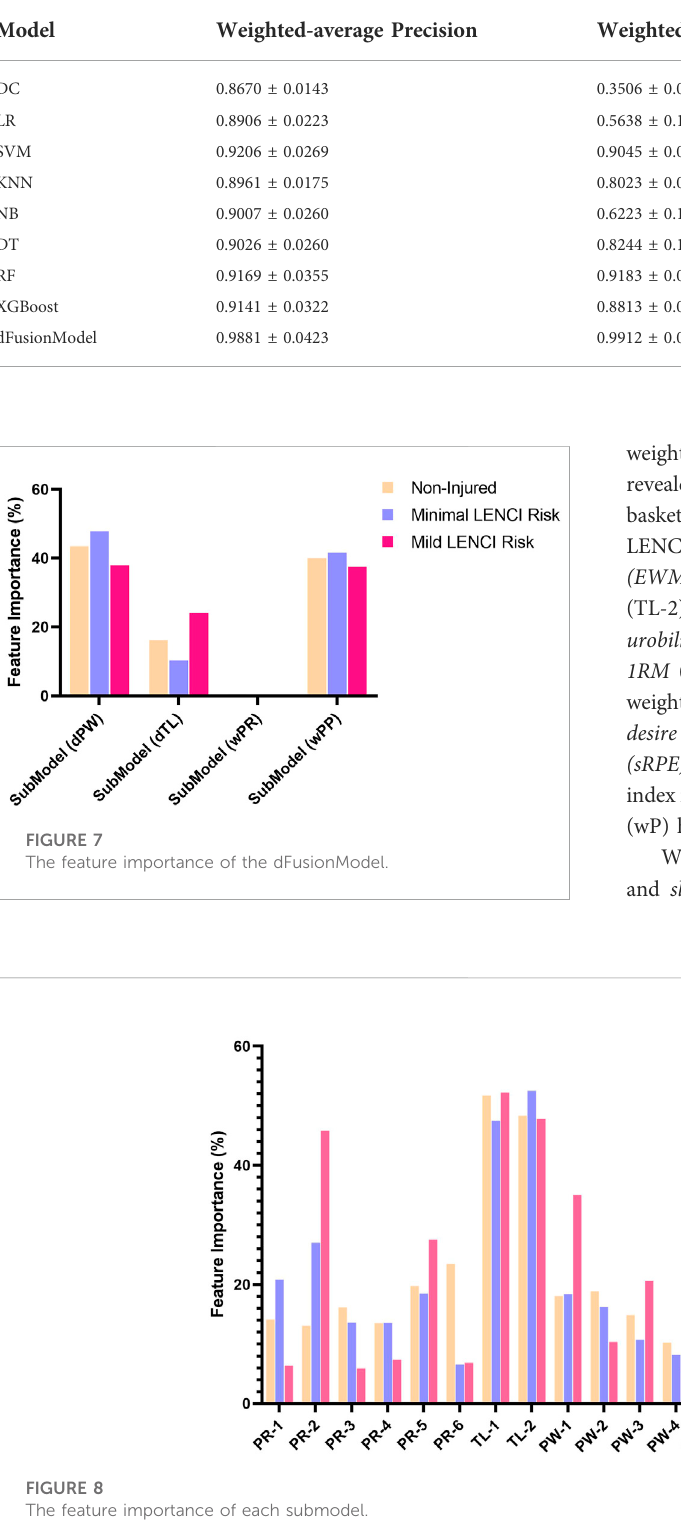
TABLE 5 Performance evaluation results of the fusion and integration schemes in dataset A.